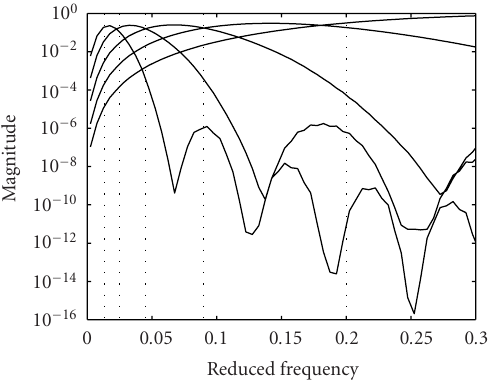
Figure 1: Magnitudes averaged over spectral rings of the nearly isotropic cubic spline wavelet filters ψ 1 , ψ 2 , ... , ψ 5 used in the sim- ulations described further down. The vertical dotted lines for ν = { 0 . 013,0 . 025,0 . 045,0 . 09,0 . 2 } delimit the five frequency bands used with SMICA in these